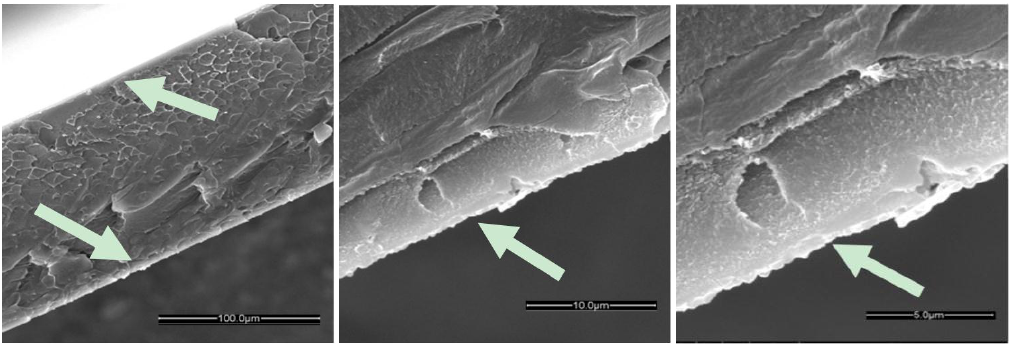
Figure 5. Cross section of the ZIF-8/HMDA-PIM-1 membrane after five ZIF-8 growth cycles. Arrow indicates the ZIF-8 layers.